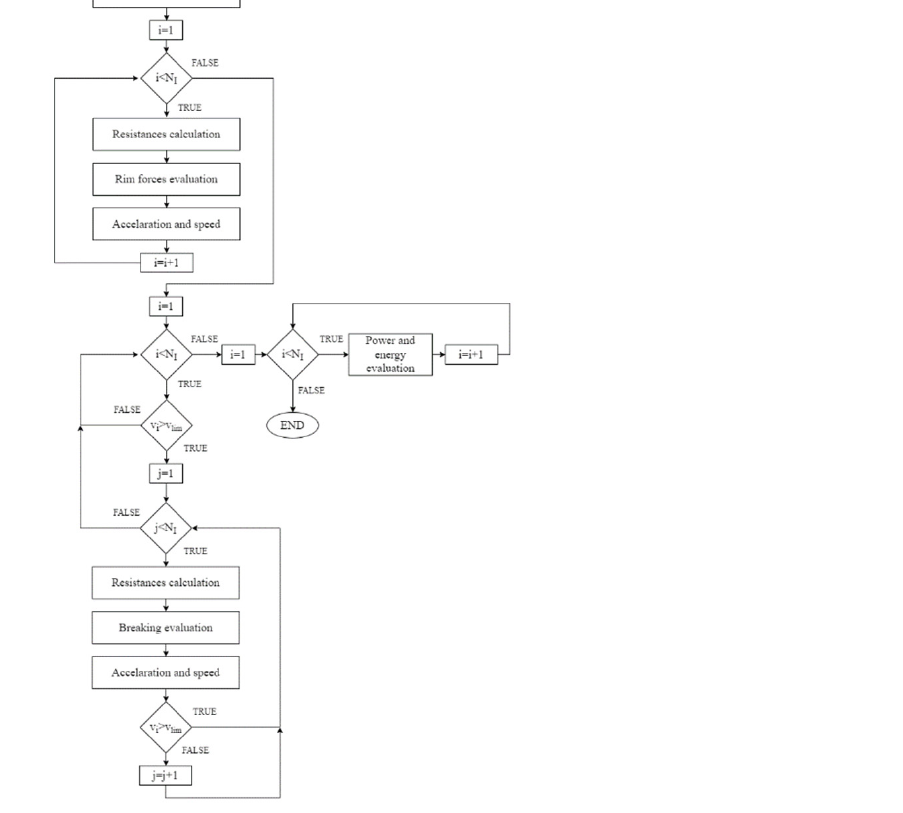
Figure 4. Flowchart of the dynamic and cinematic simulation of EVs on real point-to-point routes.